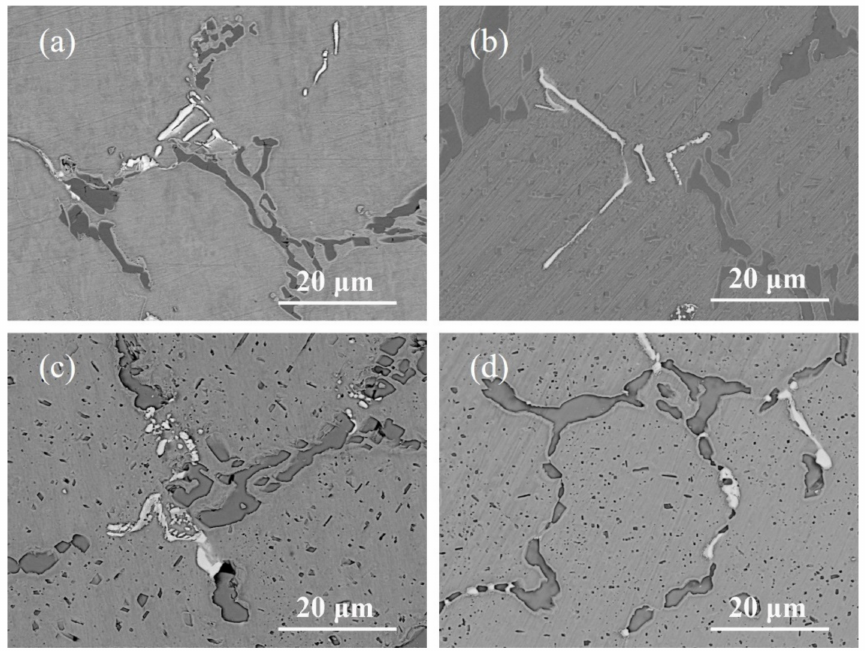
Figure 4. Typical back-scattered electron (BSE)–SEM images of ( a ) as-cast HP40Nb alloy and the samples after aging at 990 ◦ C for ( b ) 500, ( c ) 2000, and ( d ) 4000 h.